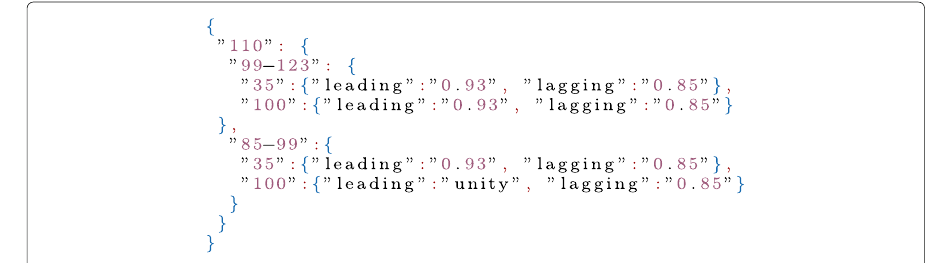
Fig. 1 Connection settings, in JSON (Crockford 2006) format, consistent with Table